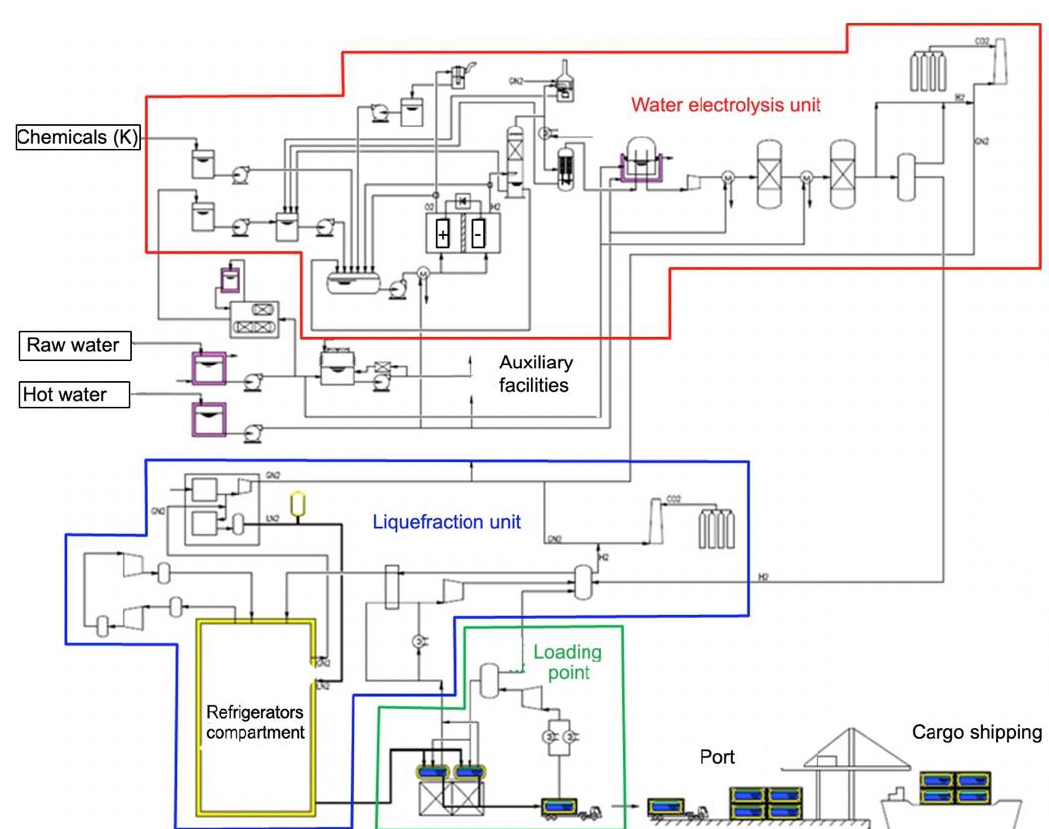
Figure 7. General block diagram of the hydrogen complex. Table 4. Calculation of hydrogen production volume by electrolysis